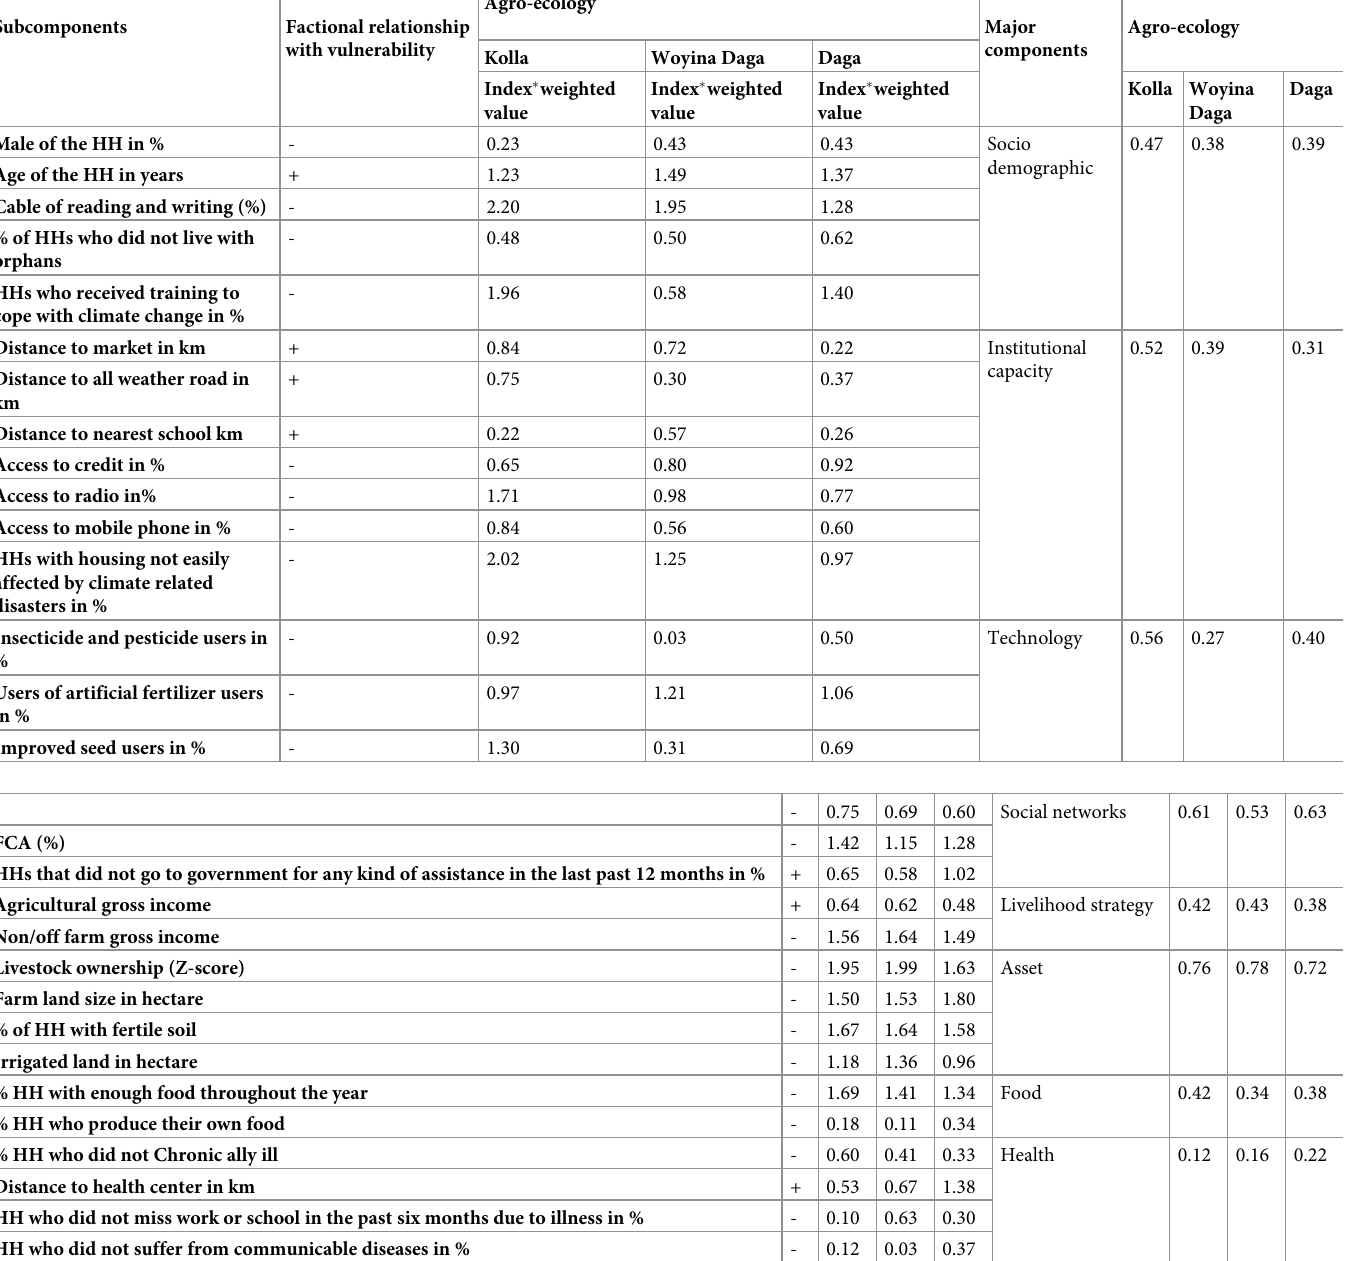
Table 4. Major components’ scores, indicator index, and weighted average of adaptive capacity